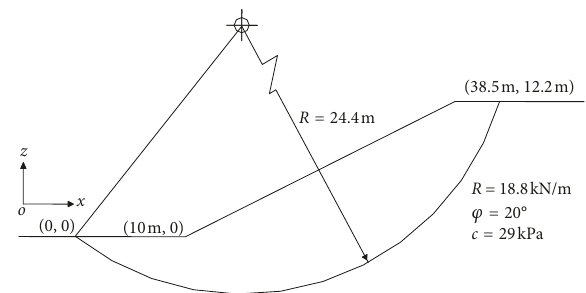
Figure 4: Cross section and parameters of a slope.